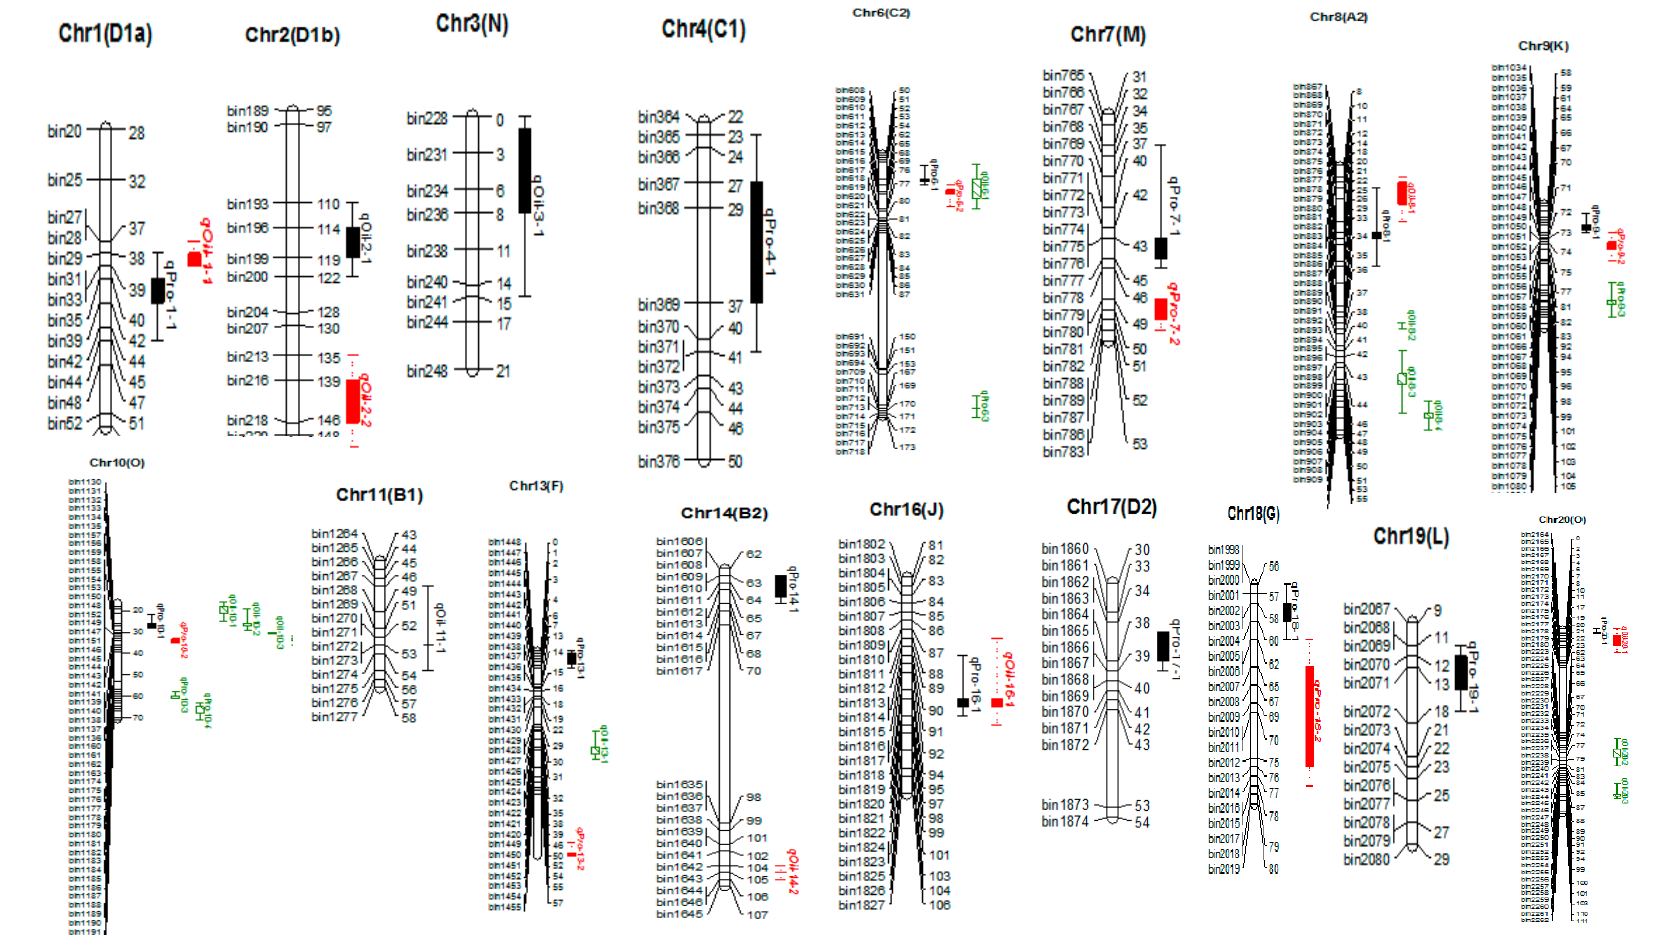
Figure 2. Chromosome location of the main-effect QTLs for seed protein and oil content (complete map is not presented here; this represents only the portion of the map where QTLs were identified). Right side of chromosomes indicates the interval distance between markers using cM (centiMogan) as the unit; the left side of chromosomes indicates Bin-DNA markers.